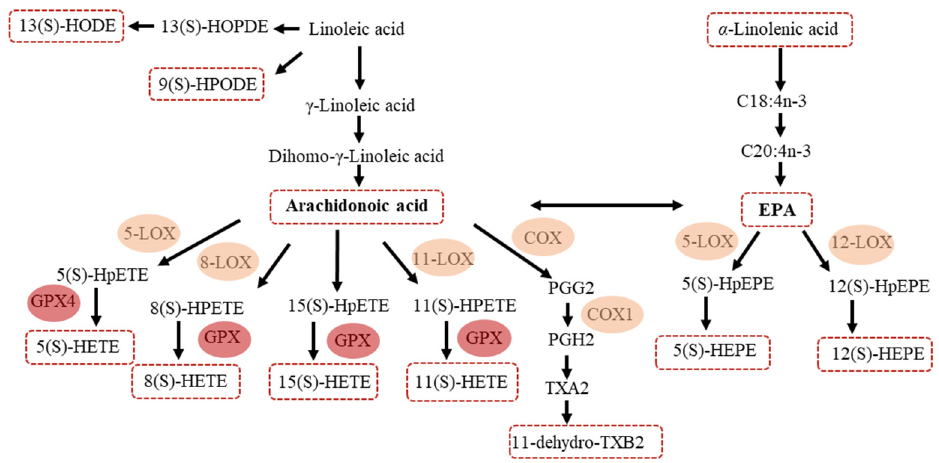
Figure 4. Eicosanoid metabolism pathway in patients with DM-SCIT and SM-SCIT. As a result, 15(S)-HETE, 5(S)-HETE, 12(S)-HEPE and 13-HODE were significantly lower after treatment, both in SM-SCIT and DM-SCIT patients. 11(S)-HETE, 8(S)-HETE, 5(S)-HEPE, AA and EPA decreased in DM-SCIT patients, and only 9(S)-HPODE increased in SM-SCIT patients (Table 2 and Figure 3a). Further analysis revealed that there were 5 downstream metabolites (5(S)-HETE, 8(S)-HETE, 11(S)-HETE, 15(S)-HETE and 11-hydro TXB2) in the ω -6-related AA and linoleic acid pathway that showed significant differences, but there was no significant change of 8(S)-HETE after SM-SCIT and in 11-hydro TXB2 after DM-SCIT. Moreover, the ω -3-related α -linolenic acid pathway including its downstream metabolites 5-HEPE and 12-HEPE exhibited significant differences after DM-SCIT, and 12-HEPE was significant decreased after SM-SCIT (Figures 3a and 4).